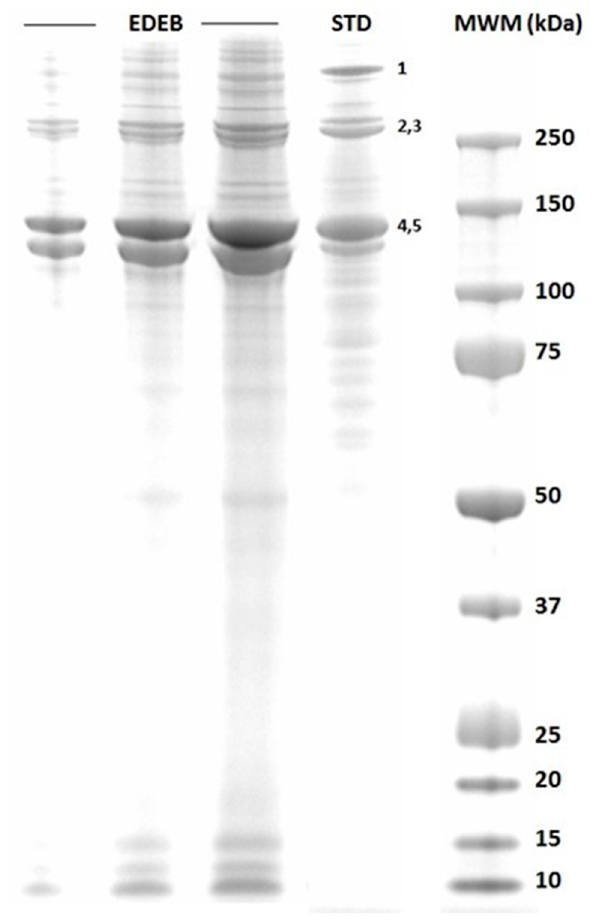
Figure 2. Sodium Dodecyl Sulfate-Polyacrylamide Gel Electrophoresis (SDS-PAGE) on an EDEB sample. The first three lanes (EDEB) correspond to different quantities of sample loaded into the gel (2, 5, 10 µ L respectively). The fourth lane (STD) corresponds to the bovine collagen standard. Molecular Weight Markers (MWM) are shown in the last lane. Band 1 corresponds to the collagen 2 α 1 1 α 2 trimer having a MW equal to 397 kDa; bands 2 and 3 correspond respectively to the α 1 α 2 and to the α 1 α 1 dimers, whose MW is respectively 268 and 258 kDa. Bands 3 and 4 correspond to the single α 2 and α 1 collagen subunits having a MW equal to 139 and 129 kDa respectively. All EDEB lanes show all 1–5 bands, corresponding to native collagen, and few other bands possibly corresponding to collagen degradation products. The intensity of 1–5 bands in EDEB lanes, much higher than that of all the other bands, indicates that most, if not all, collagen is in its native